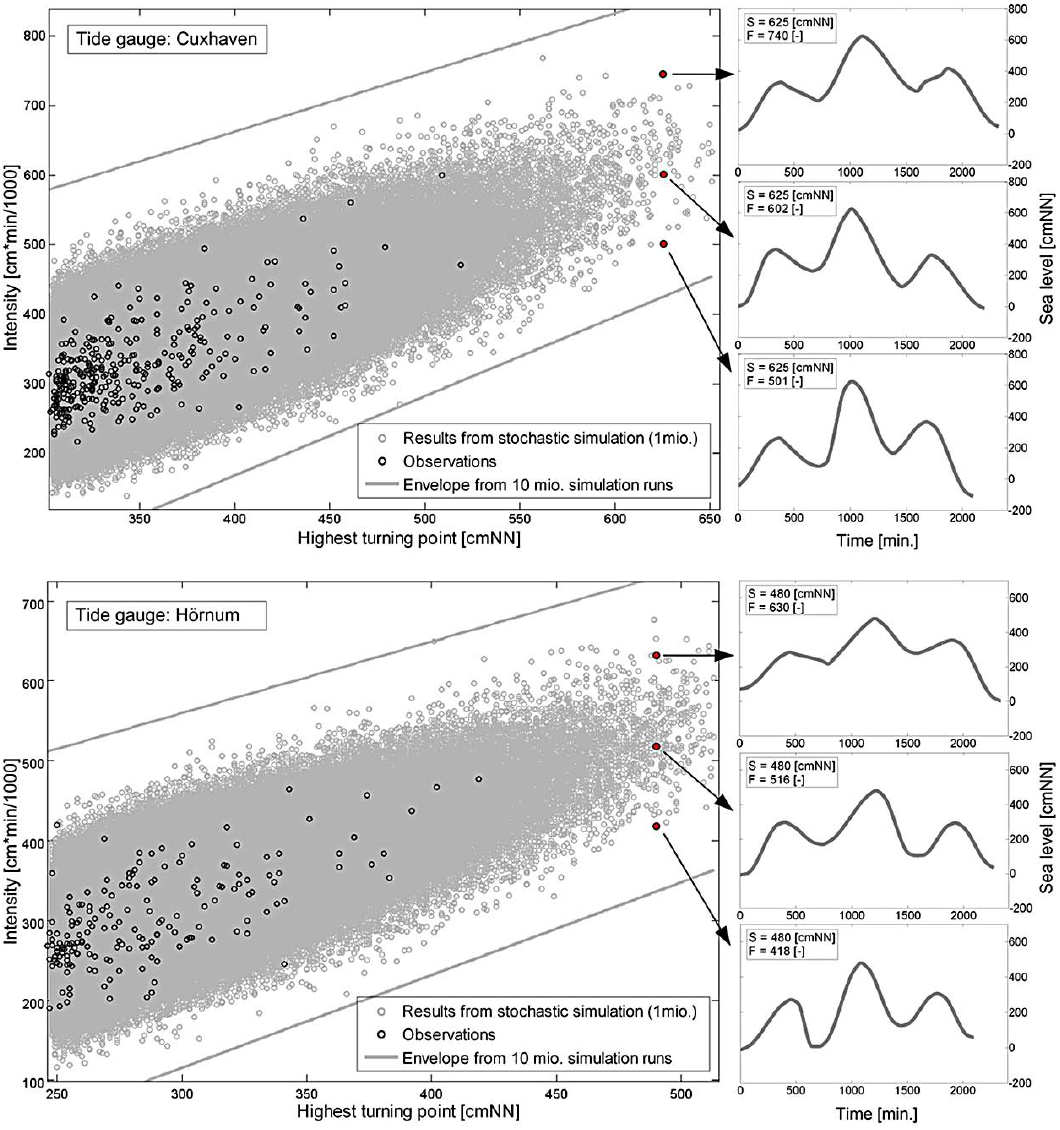
Fig. 14. Results from simulating 10 million storm surges, represented by the parameters “highest turning point” and “intensity” for the tide gauges of Cuxhaven (top) and H¨ornum (bottom) and selected high resolution and stochastically simulated storm surge curves (right).